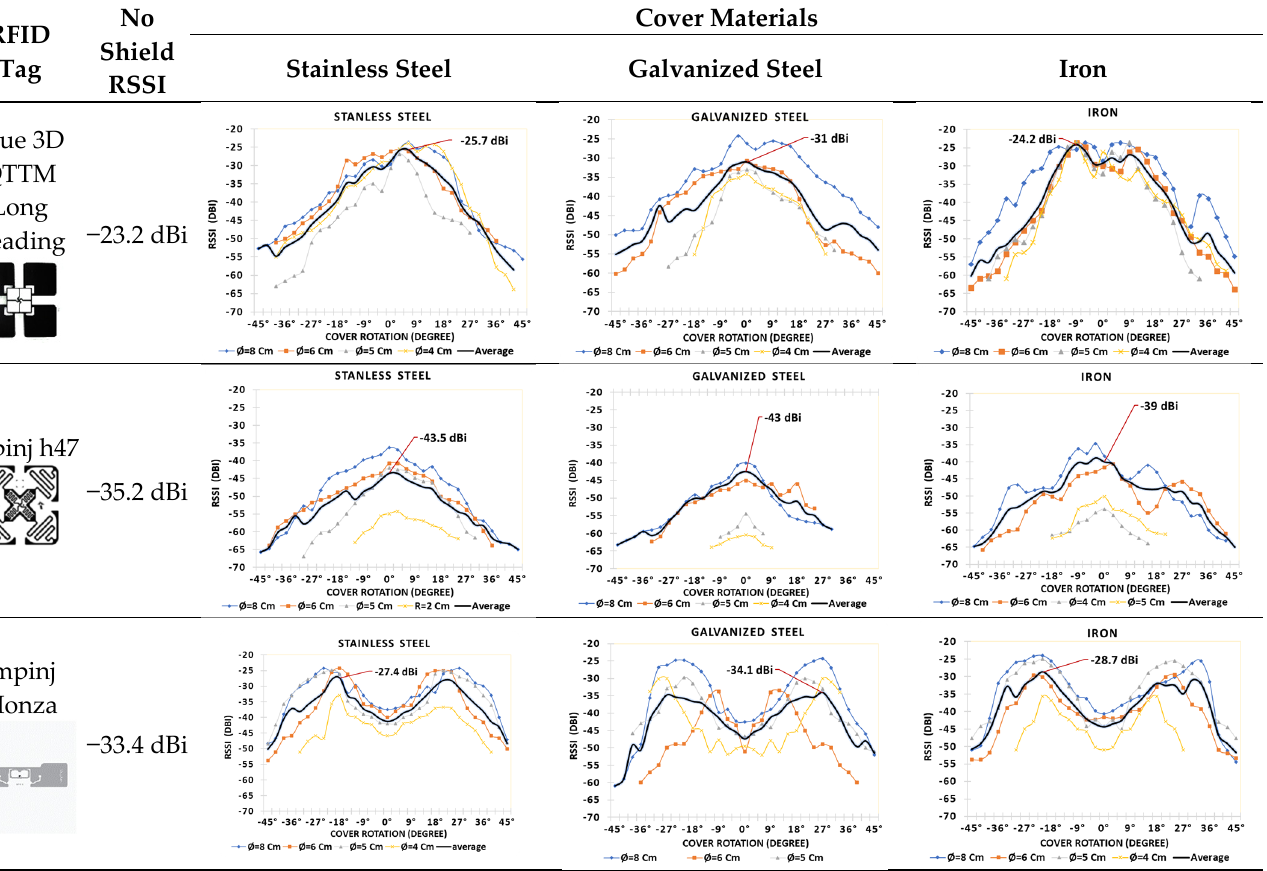
Figure 6. RSSI measured for RFID tags with different covering materials .